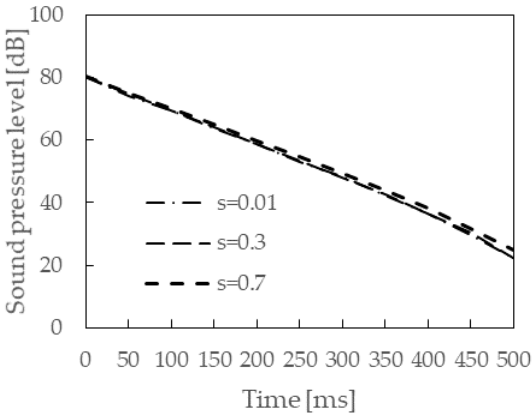
Figure 4. Decay curves related to the reverberation chamber under surface scattering coe ffi cients of di ff erent values.